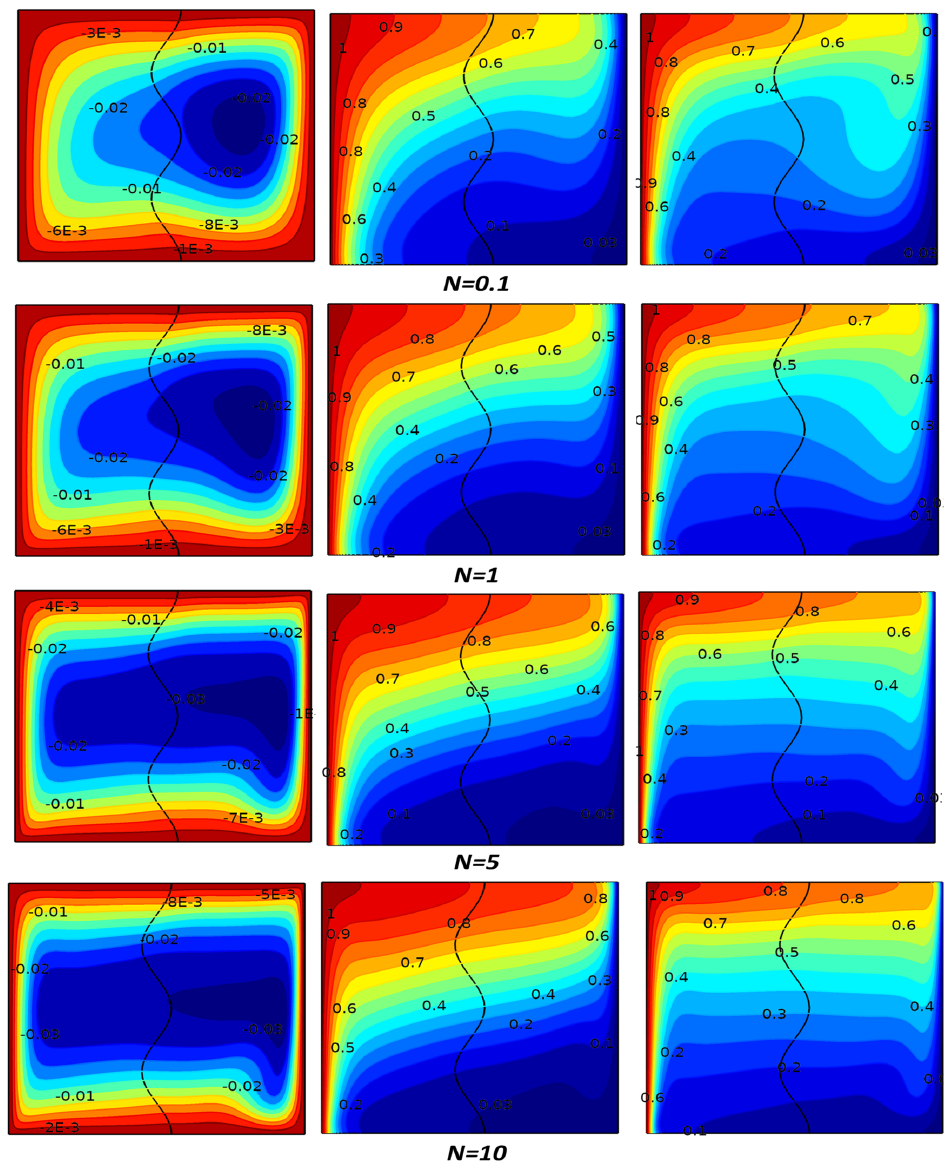
Figure 11. Streamlines (column 1), isotherms (column 2), and isoconcentration (column 3).